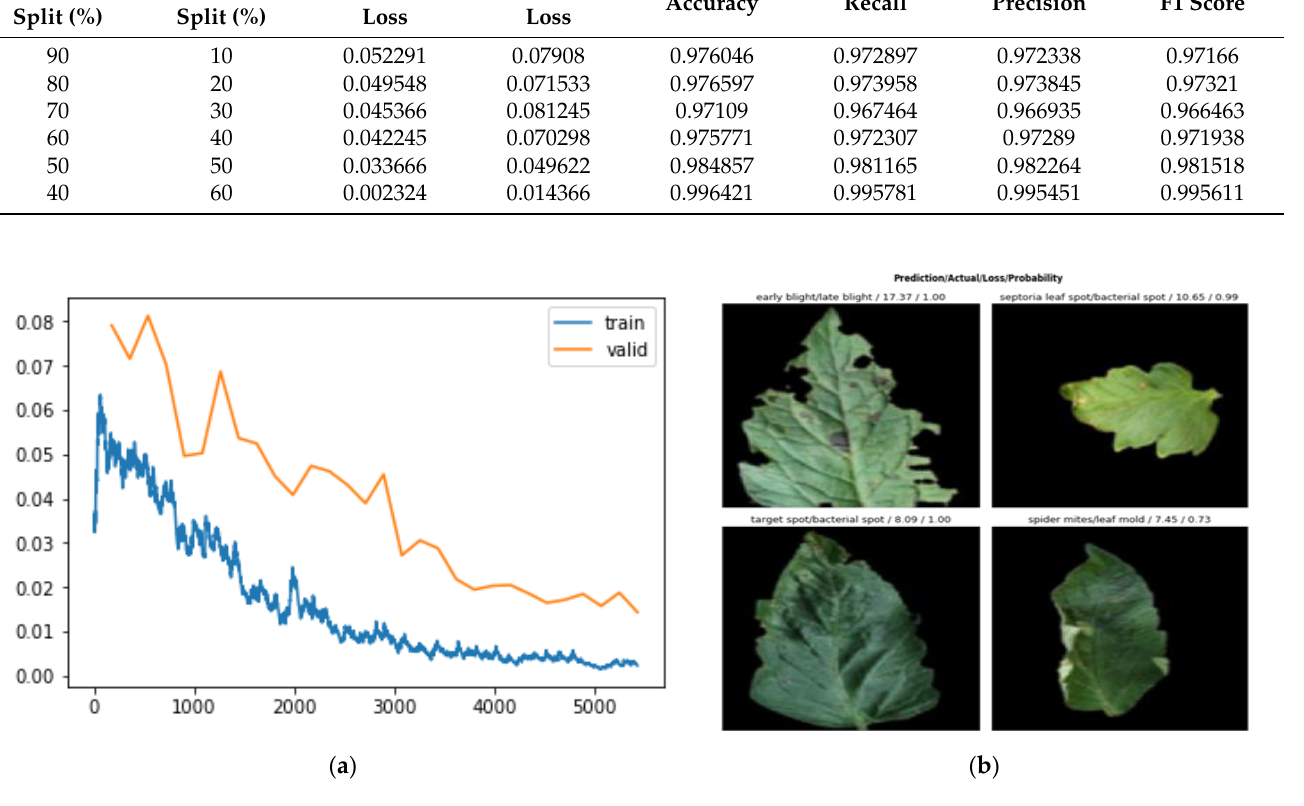
Figure 11. Showing the mistakes recorded by the model in our research: ( a ) showing the plot loss for ResNet-152; ( b ) showing the images the model predicted wrongly for ResNet-152, showing the predicted, ground truth, loss, and probability